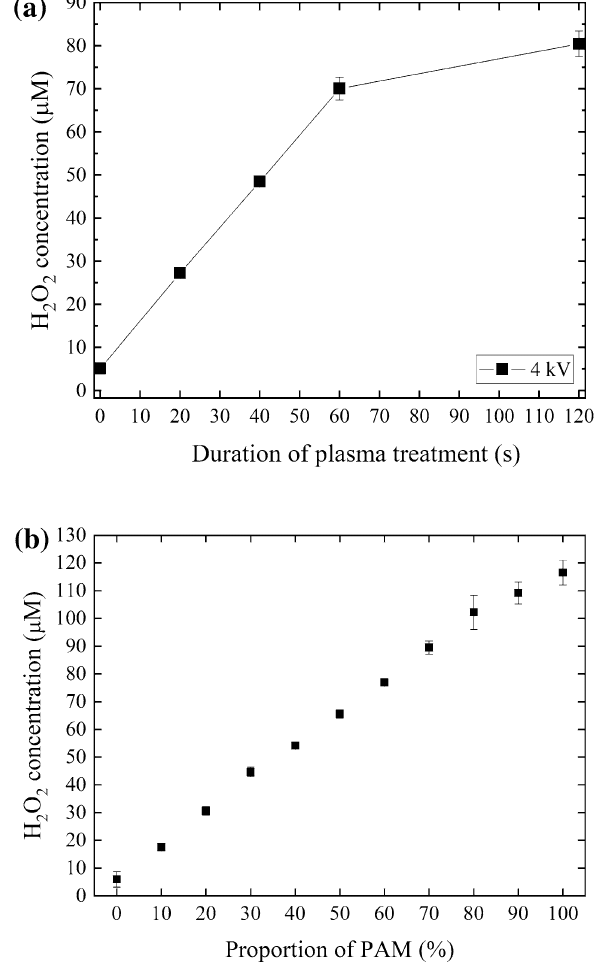
Figure 4. ( a ) H 2 O 2 concentration in PAM prepared with different exposure times. ( b ) PAM produced using a 120-s exposure time was serially diluted with untreated RPMI medium, and the H 2 O 2 concentrations were measured for PAM present at different proportions. Data are mean and SD values (n =